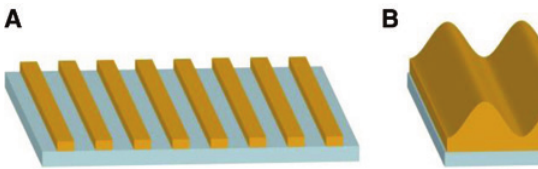
Figure 7: Various gratings used for